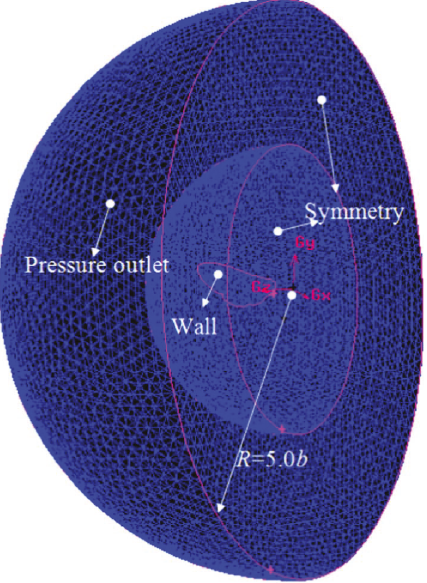
Figure 3: The computational grid and boundary